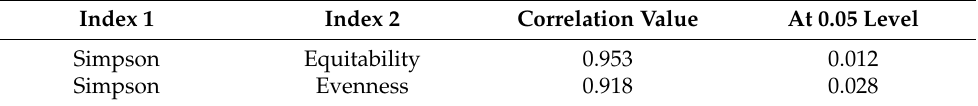
Table 5. Correlation statistics of the height inequality and diversity measures in the Hilltop stand of the Omo Forest